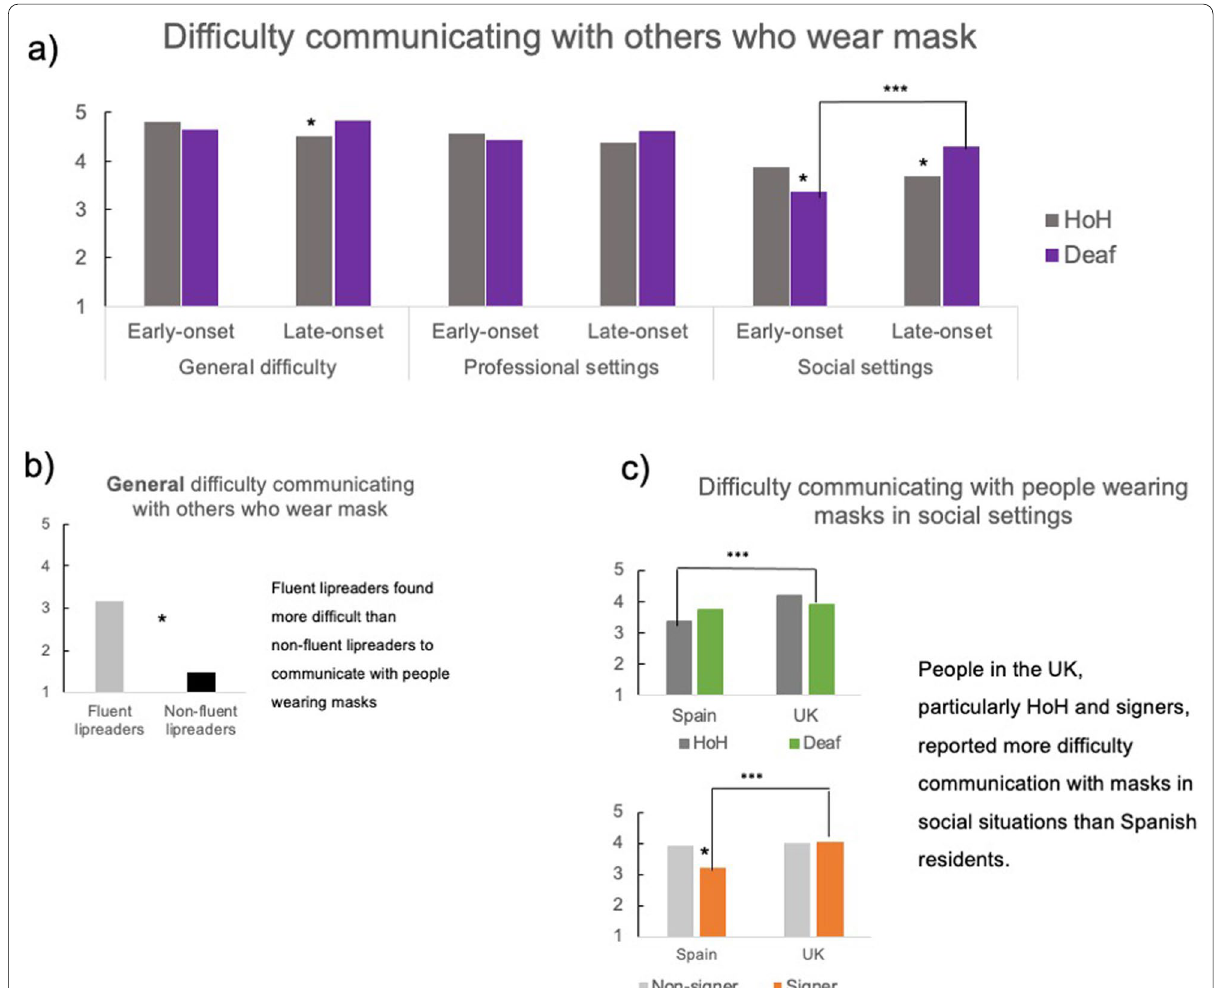
Fig. 3 Overview of significant effects for the three measures of experienced difficulty communicating with people who wear masks: Level by onset of deafness interaction in general as well as professional and informal social situations ( a ), main effect of lipreading fluency in the general difficulty measure ( b ) and country of residence by level of deafness and Knowledge of SL interactions for the informal social settings ( c ). Effects that were significant in the simple slopes analysis are coded as follows, ***